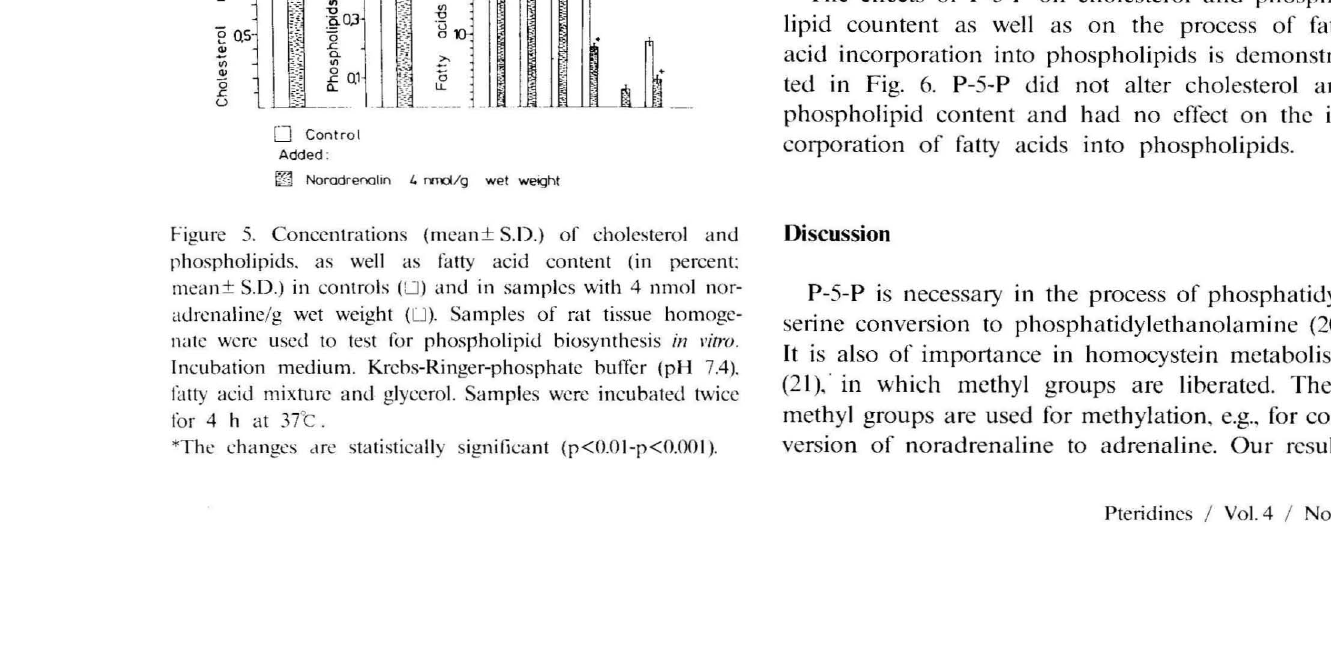
(p<O.OOl), while the amount of phospholipids was not altered. Fig. 5 pictures changes of phospholipid biosyn thesis after addition of noradrenaline to